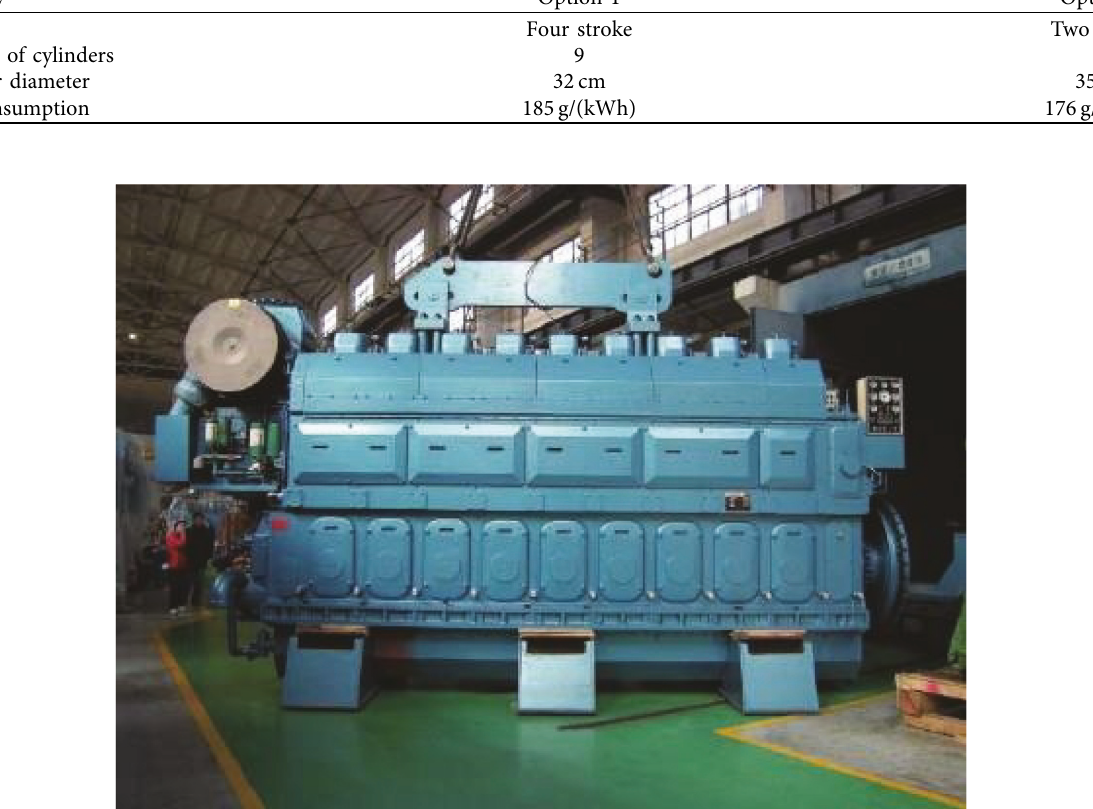
Figure 5: Physical views of the 9G32 diesel engine.